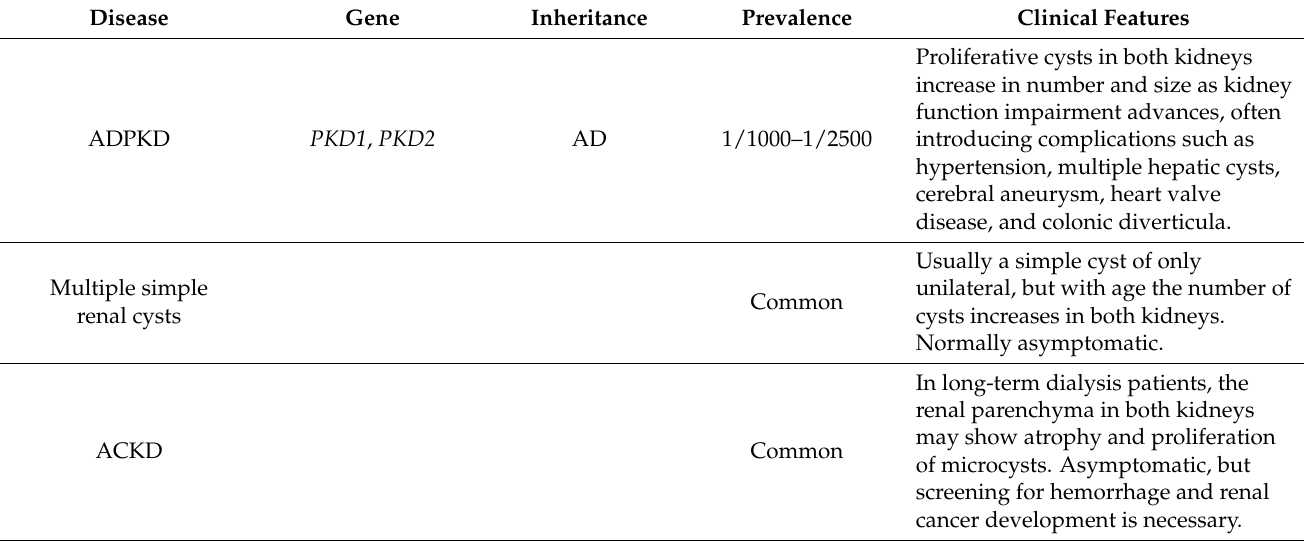
Table 1. Summary of cystic kidney